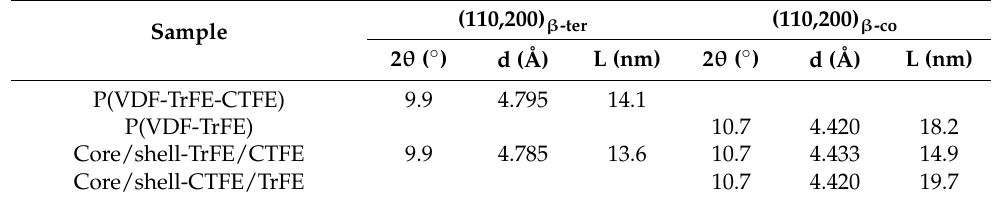
Table 1. The 2 θ , lattice spacing, and crystallite size of the (110,200) β reflection in the single and coaxial electrospun nanofibers.